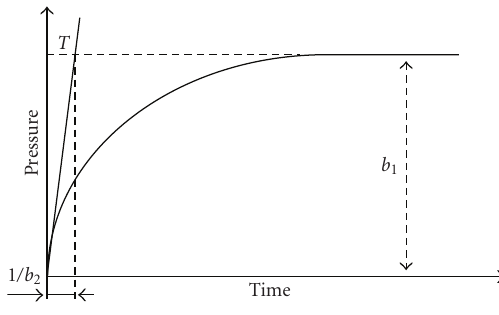
Figure 1: Exponential curve y = b 1 (1 − e − b 2 x ).